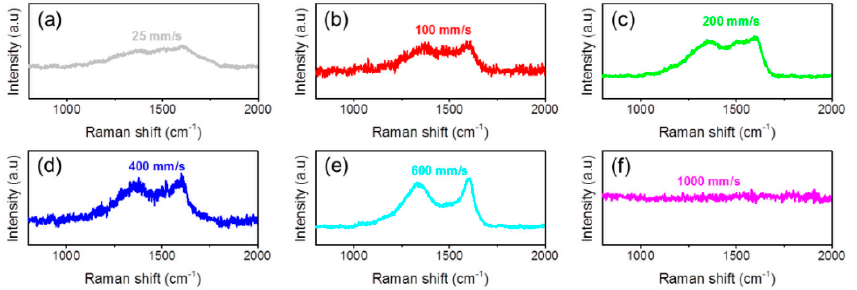
Figure 7. Raman spectra of the worn surfaces on Al 2 O 3 sliding against H-DLC under different sliding velocities. ( a ) 25, ( b ) 100, ( c ) 200, ( d ) 400, ( e ) 600, and ( f ) 1000 mm/s.